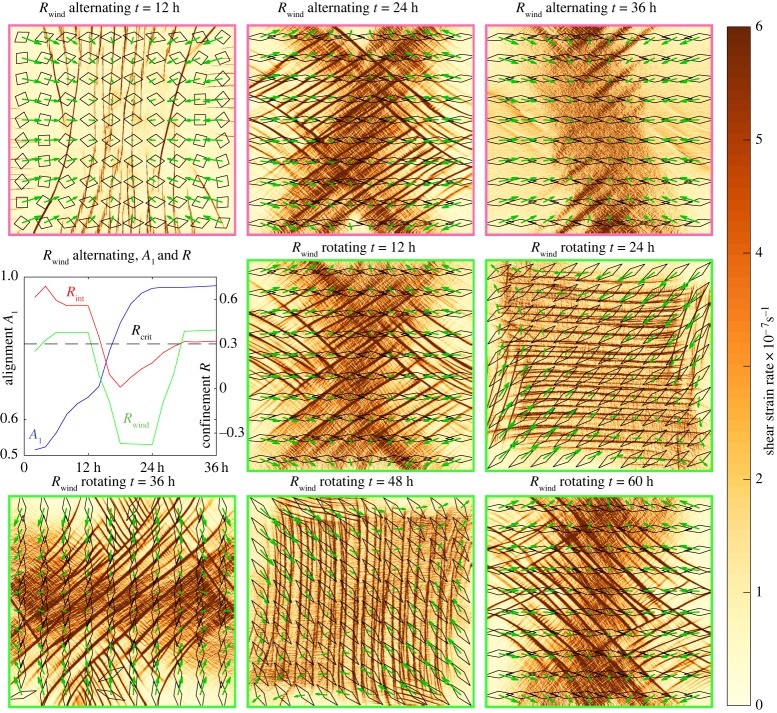
Sea shear strain rate for runs with changing wind conditions with local sea ice structure as indicated by the overlaying quadrilaterals and forcing wind field as shown by the green arrows. The three frames outlined in pink and the line plot are for a run with winds that alternate through Rwind = (0.4,  − 0.4, 0.4) every 12 h as seen in the green overlaying arrows and the green line. The red line shows the sea ice internal stress confinement Rint and the blue line the average level of anisotropy A1. The plots outlined in green are for winds of Rwind =  − 0.4 that rotate around the centre of the grid by 45° anticlockwise every 12 h as seen in the green overlaying arrows. The changing wind fields are created by setting the winds every 6 h and allowing the model to interpolate in-between. The colour of the plot borders corresponds to the colour of the extra lines on the cumulative strain plots in figure 7.